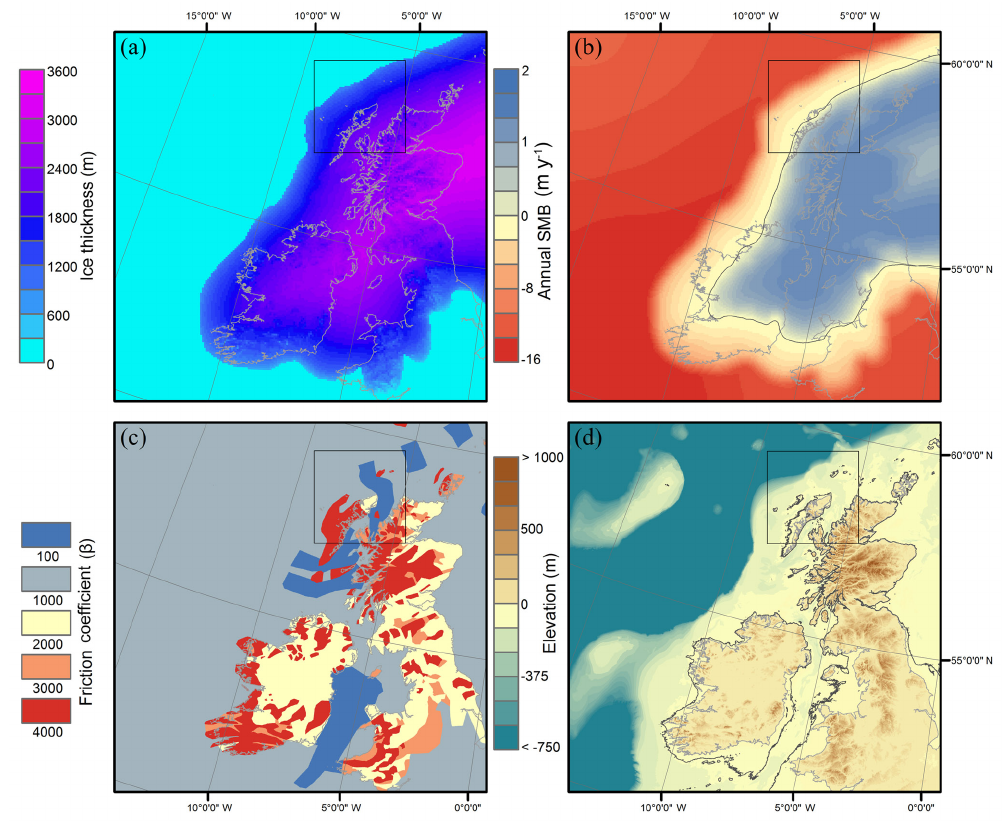
Figure 2. Initial conditions and boundary conditions for the equilibrium spin-up lLGM ice sheet simulation, showing the full domain of the simulations. The contemporary coast is shown as a thin grey line. (a) Initial ice thickness (m); (b) annual surface mass balance (myr − 1 ), with the black contour line representing the equilibrium line (SMB = 0mw.e.yr − 1 ). (c) Bed friction coefficient ( β) ; (d) isostatically adjusted bed topography (m) corresponding to 30kaBP. The maps show the full ice sheet domain and the black boxes indicate the area of model grid refinement referred to as the Minch